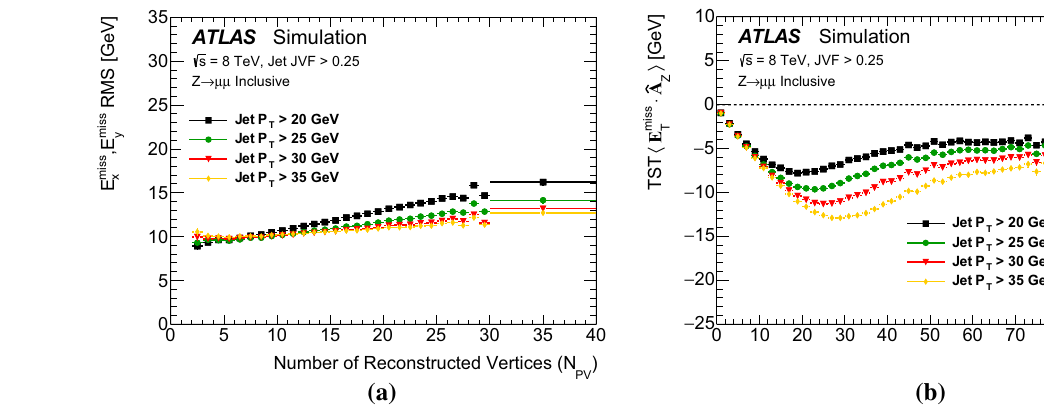
the Z → μμ simulation.JVF > 0.25isrequiredforalljetswith p T > 20 GeV and | η | < in T